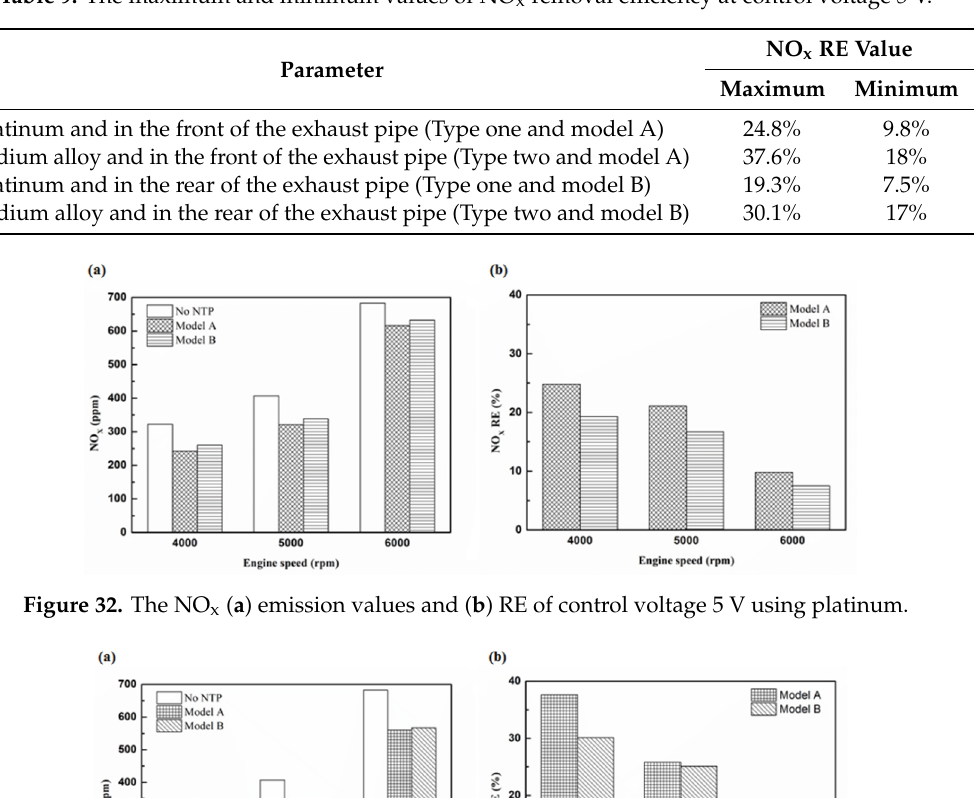
Figure 34. The NO x RE at control voltage 5 V. Table 9. The maximum and minimum values of NOx removal efficiency at control voltage 5 V. Parameter